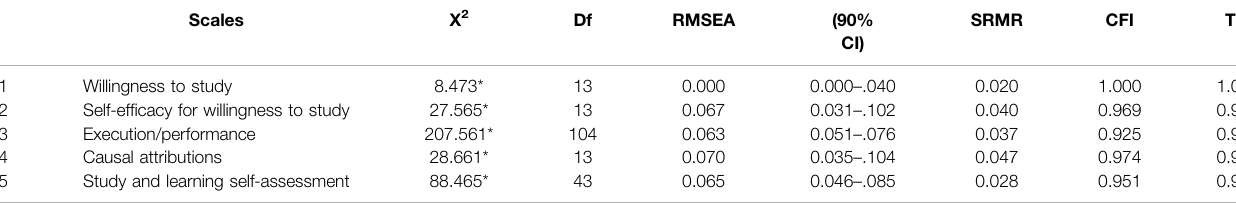
TABLE 1 | CFA model estimations of the fi ve Scales of